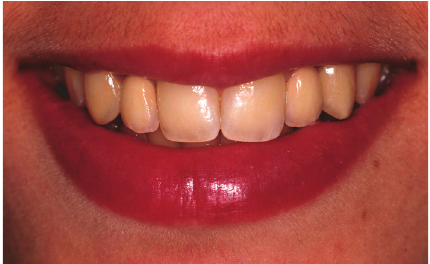
Figure 5: Final aspect after performing the finishing and polishing procedures, in which more harmonious and rounded contours, more in keeping with the patient’s face and gender, may be